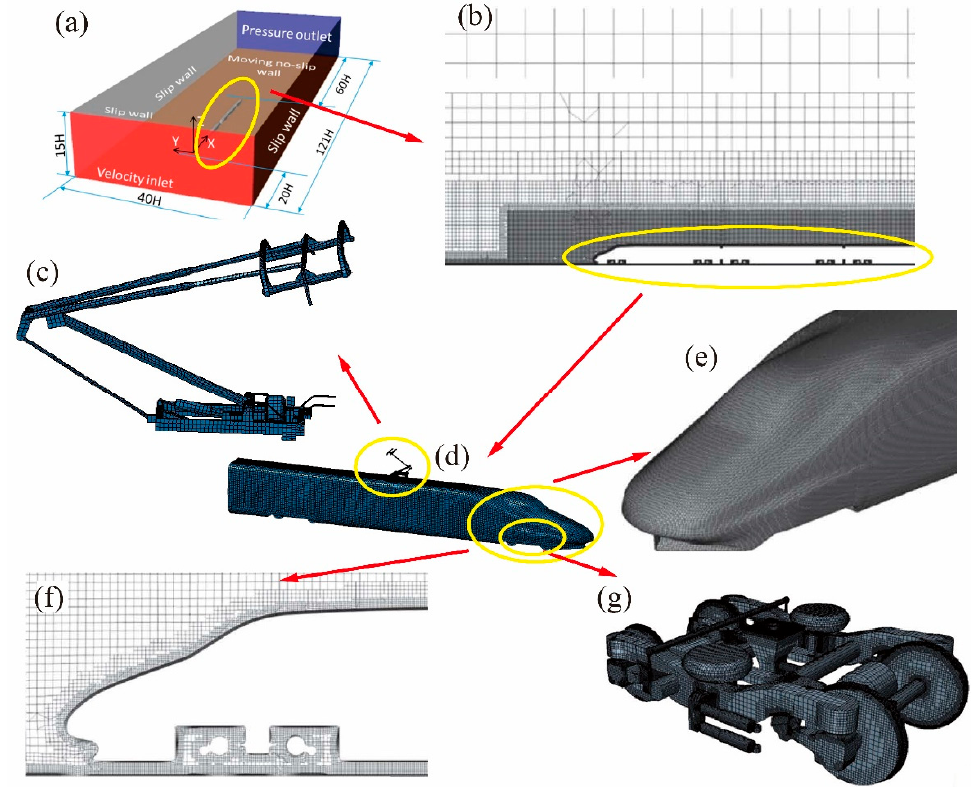
Figure 4. CFD meshing for high-speed trains. ( a ) Schematic of flow field computational domain [56]; ( b ) grid density variation in the computational domain [56]; ( c ) pantograph meshing [57]; ( d ) high-speed train complete grid [57]; ( e ) high-speed train head meshing [56]; ( f ) high-speed train head grid density variation [56]; ( g ) bogie meshing [58].